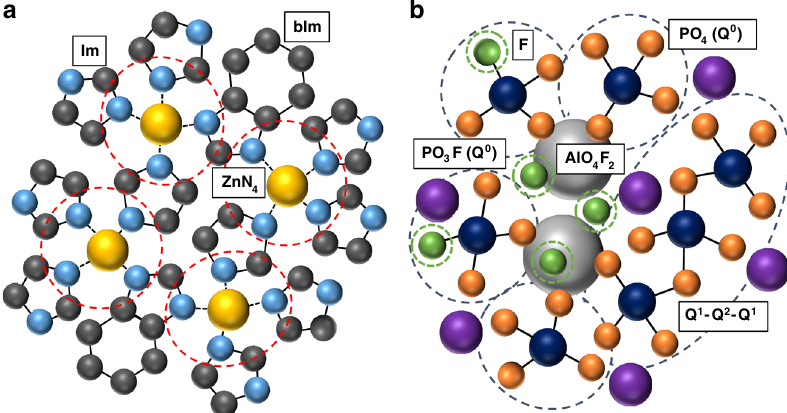
Fig. 1 Structural chemistries. 2D representations of a The structure of ZIF-62, showing ZnN 4 tetrahedra connected by imidazolate (Im) and benzimidazolate (bIm) organic ligands and b the local structure of the ( 1 − x )([Na 2 O] z [P 2 O 5 ])- x ([AlO 3/2 ][AlF 3 ] y ) glass series, where z and y represent 1: z and 1: y ratios of P 2 O 5 : Na 2 O and AlO 3/2 : AlF 3 , respectively. The inorganic glasses are composed of varying lengths of phosphate tetrahedra chains and Al (OP) 4 F 2 octahedra with Na + as the counter cation. Key: N — light blue, Zn — yellow, C — dark grey, P — dark blue, O — orange, Al — light grey, F — green, Na — purple, H — omitted for clarity. Inorganic structure adapted from Le et al. 22 with permission.